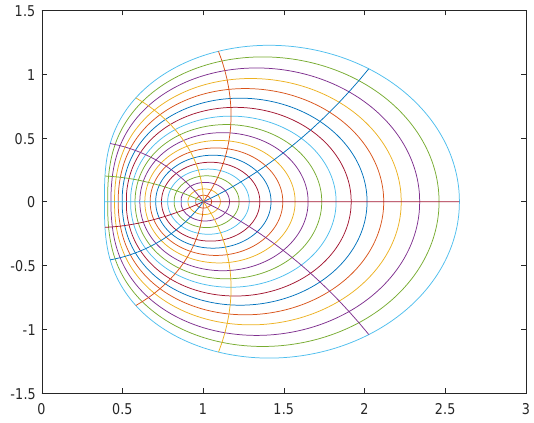
Figure 1. Image of D under e z .